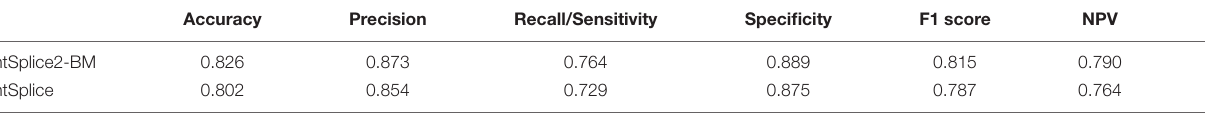
TABLE 2 | Seven statistical measures of IntSplice2-BM and IntSplice models using Test Dataset-288, which has no circularity with the respective training datasets.